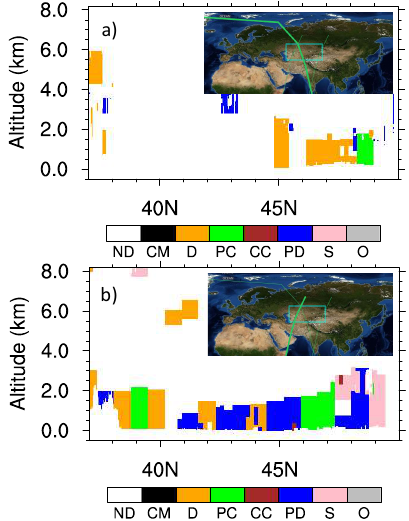
Figure 12. Vertical Feature Mask (VFM) from CALIPSO for a dust storm occurring during daytime ( a ) and during nighttime ( b ) on 7 May 2007 over the Aral Sea Basin. Subplots in both plots show the CALIPSO track, as indicated by green line over Central Asia (the domain is labeled by green boxes). ND: not determined; CM: clean marine; D: dust; PC: polluted continental; CC: clean continental; PD: polluted dust; S: smoke; O: other.